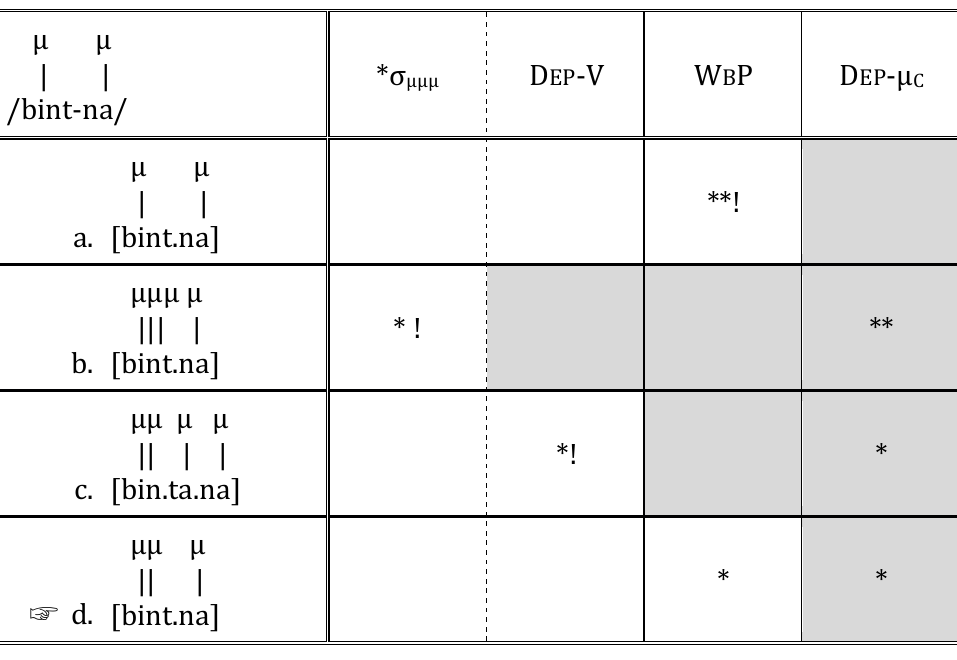
Tableau 8: Since D EP -μ C is the lowest ranked and *σ μμμ is a highly ranked constraint, the winning candidate surfaces with one epenthesized mora, the faithful candidate loses by two violations of W B